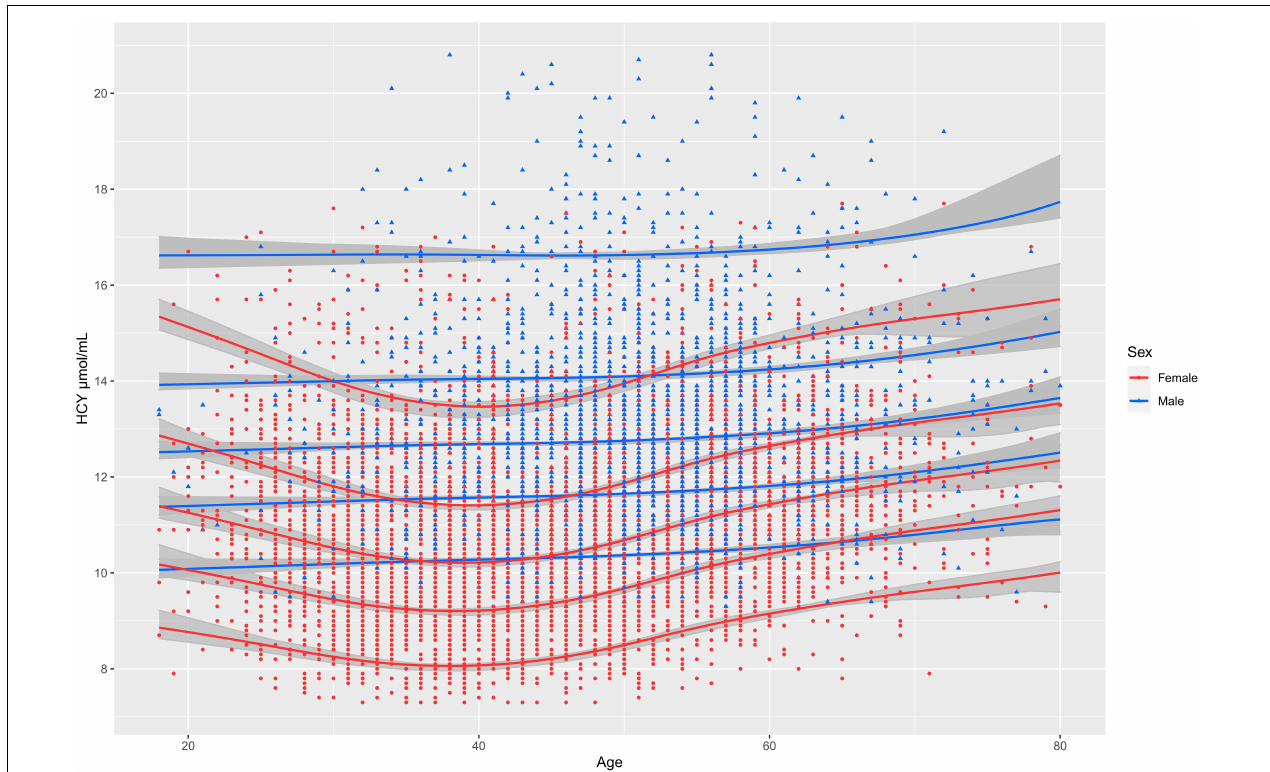
FIGURE 3 | The solid lines from top to bottom represent the 95th, 75th, 50th, and 25th, 5th quantiles of concentration of Hcy, respectively; The gray shadows represent 95% confidence intervals for each percentile